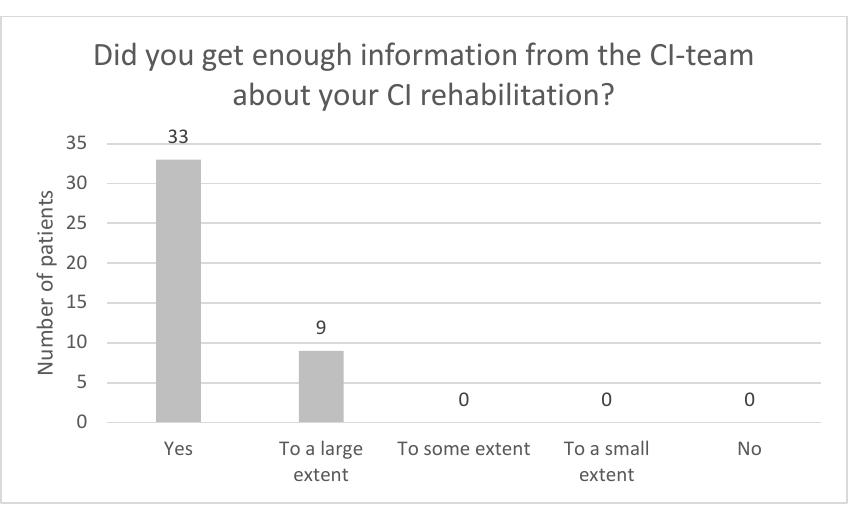
Figure 9. Did you obtain enough information from the CI team about your rehabilitation?